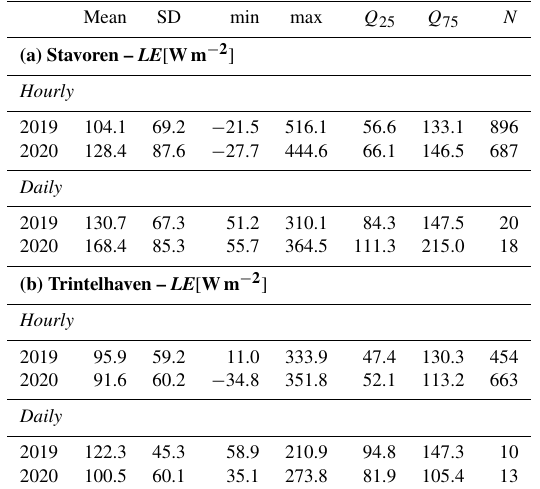
Table B1. Basic statistics of the latent heat flux during the summer periods of 2019 and 2020 at both locations (i.e. Stavoren and Trintelhaven) at the hourly and daily timescale. The statistics given are the mean, standard deviation, minimum, maximum, 25th and 75th quantile, and the number of observation points.